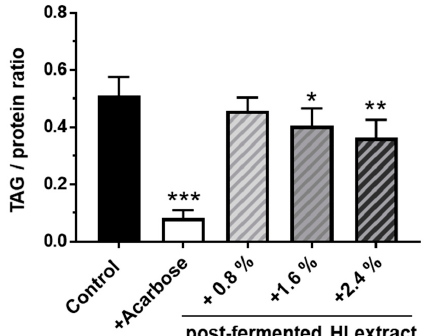
Figure 7. Supplementation of post-fermented HI-rich soy extract decreased the triacylglyceride